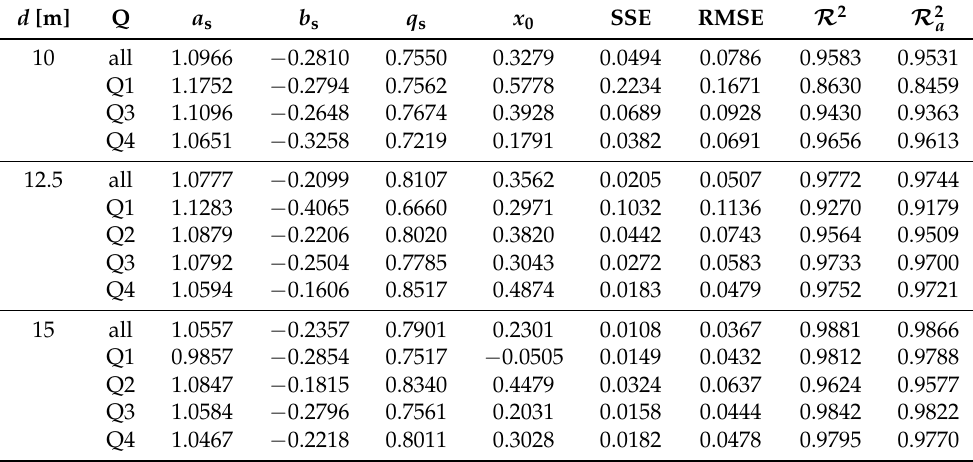
Table 3. Coefficients of the models for short freeze lengths x ∈ X s